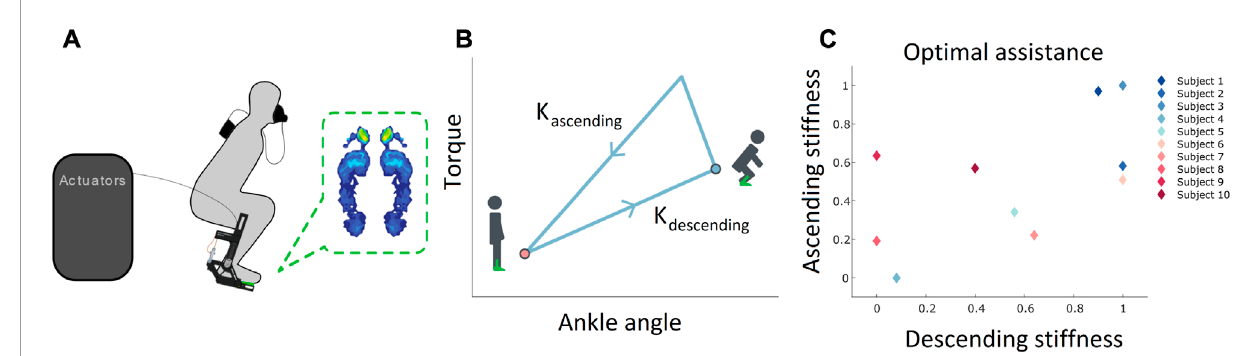
FIGURE 2 Experimental setup of exoskeleton personalization study for squatting using human-in-the-loop (HIL) optimization and its results (A) . Experimental setup image showing the human subject wearing the ankle exoskeleton, off-board actuators, foot pressure sensors (in green dashed box) and metabolic cost measurement device (B) . Ankle angle versus the desired torque trajectory for control of the exoskeleton during squatting. The K ascending parameter is the proportional stiffness when the subject is performing the ascending motion from the bottom position of the squat and K descending is the proportional stiffness when the subject is descending into the bottom position of the squat (C) . The optimal stiffness parameters were determined from HIL optimization, for each subject.